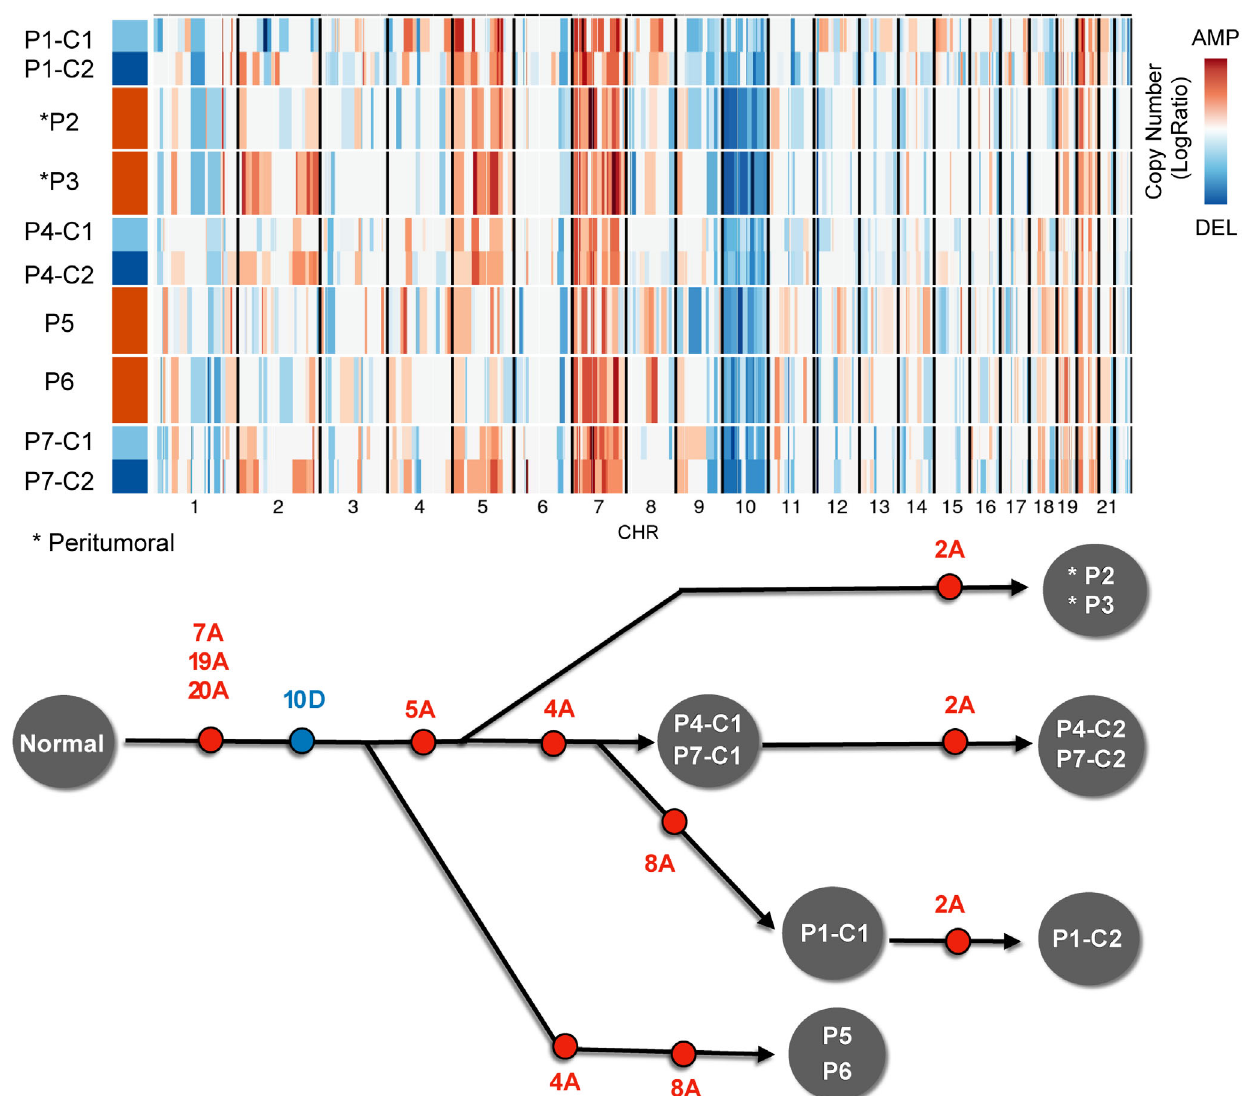
Fig. 6 | Temporal deconvolution of the clonal substructure. Compact repre- sentation of clonal structure inferred with SCEVAN of multiregional scRNA-seq